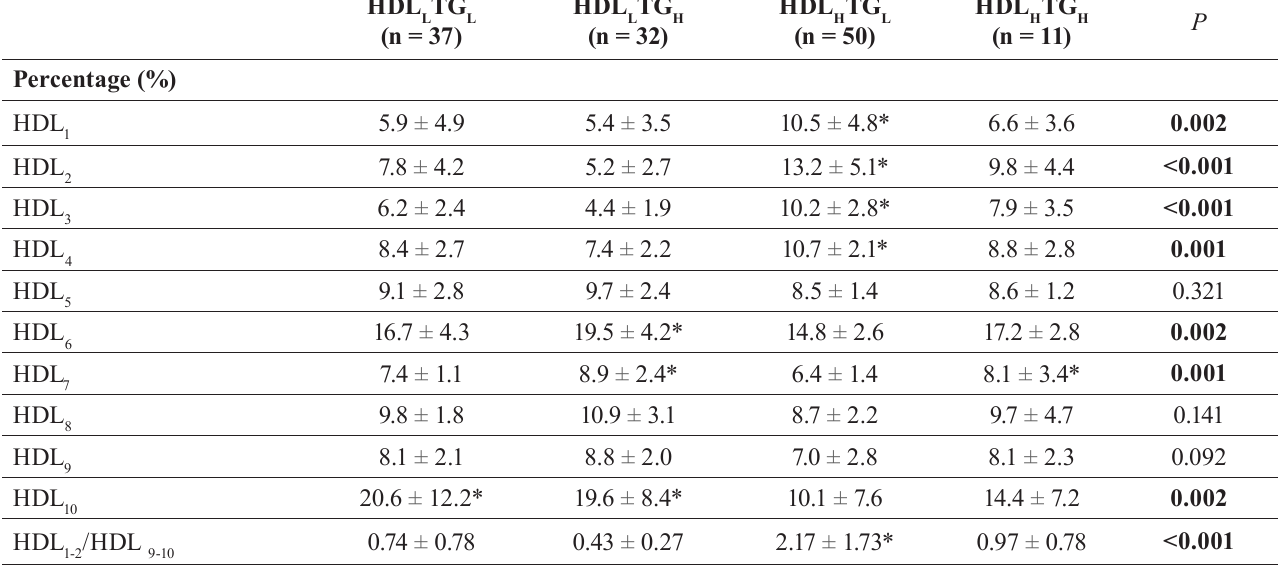
The variables were expressed as mean ± (standard deviation); HDL TG = low HDL-c and low triglycerides; L L HDL TG = low HDL-c and high triglycerides; L H HDL TG = high HDL-c and low triglycerides; H L HDL TG = high HDL-c and high triglycerides; H H HDL= high density lipoprotein.